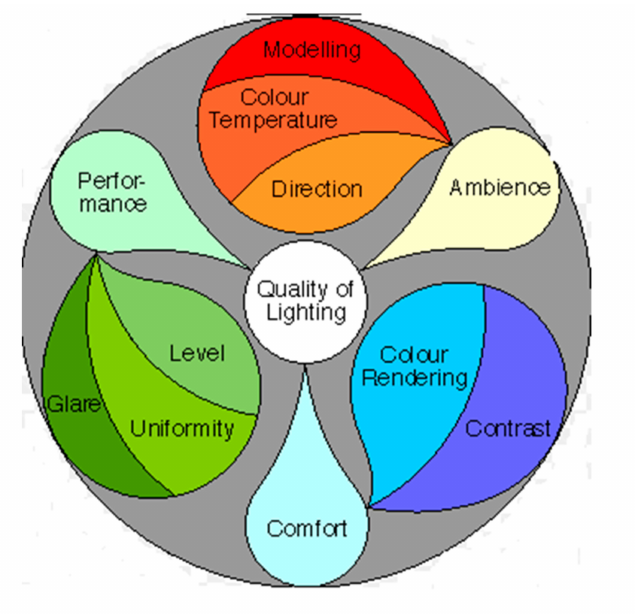
Figure 1. Factors a ff ecting proper lighting [15].